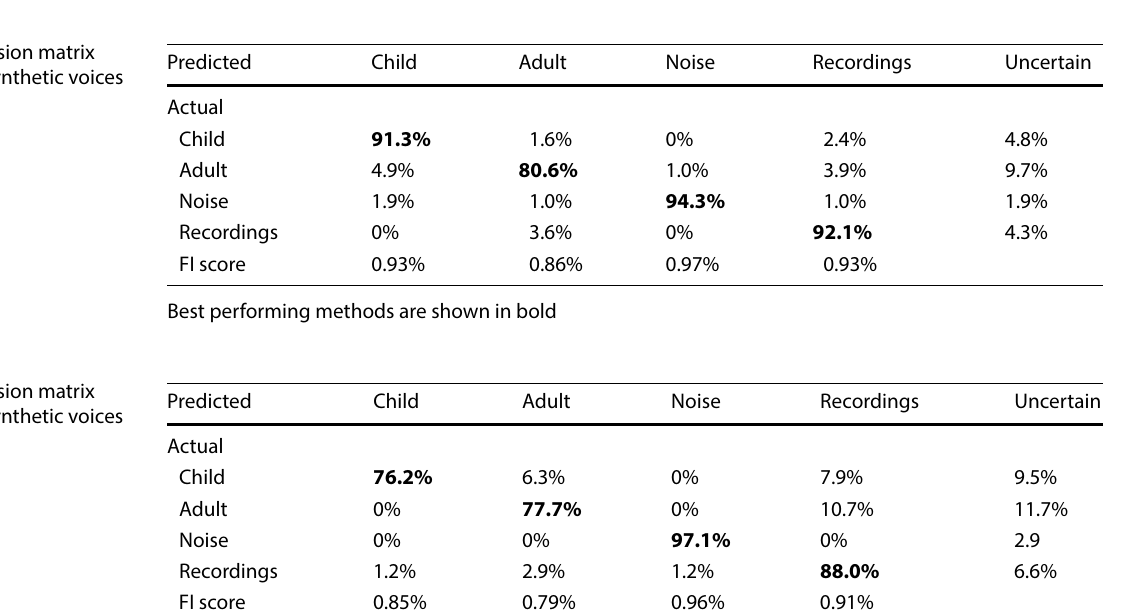
Best performing methods are shown